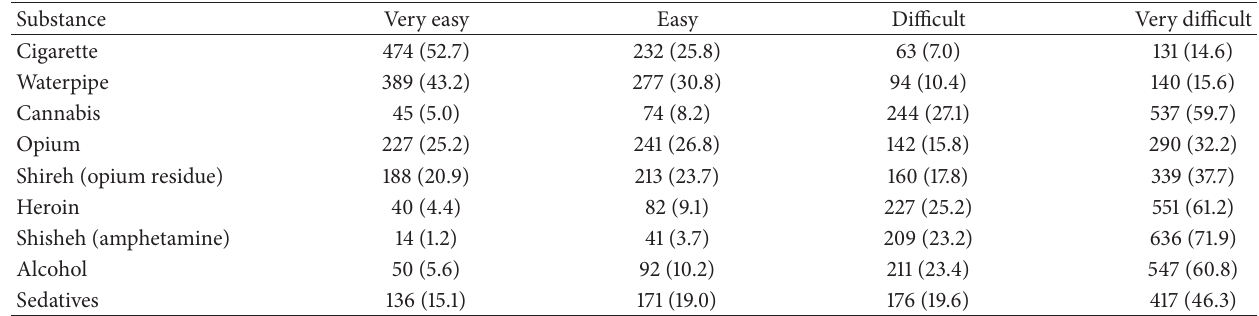
Table 4: Perceived difficulty in getting each of drugs ∗ .